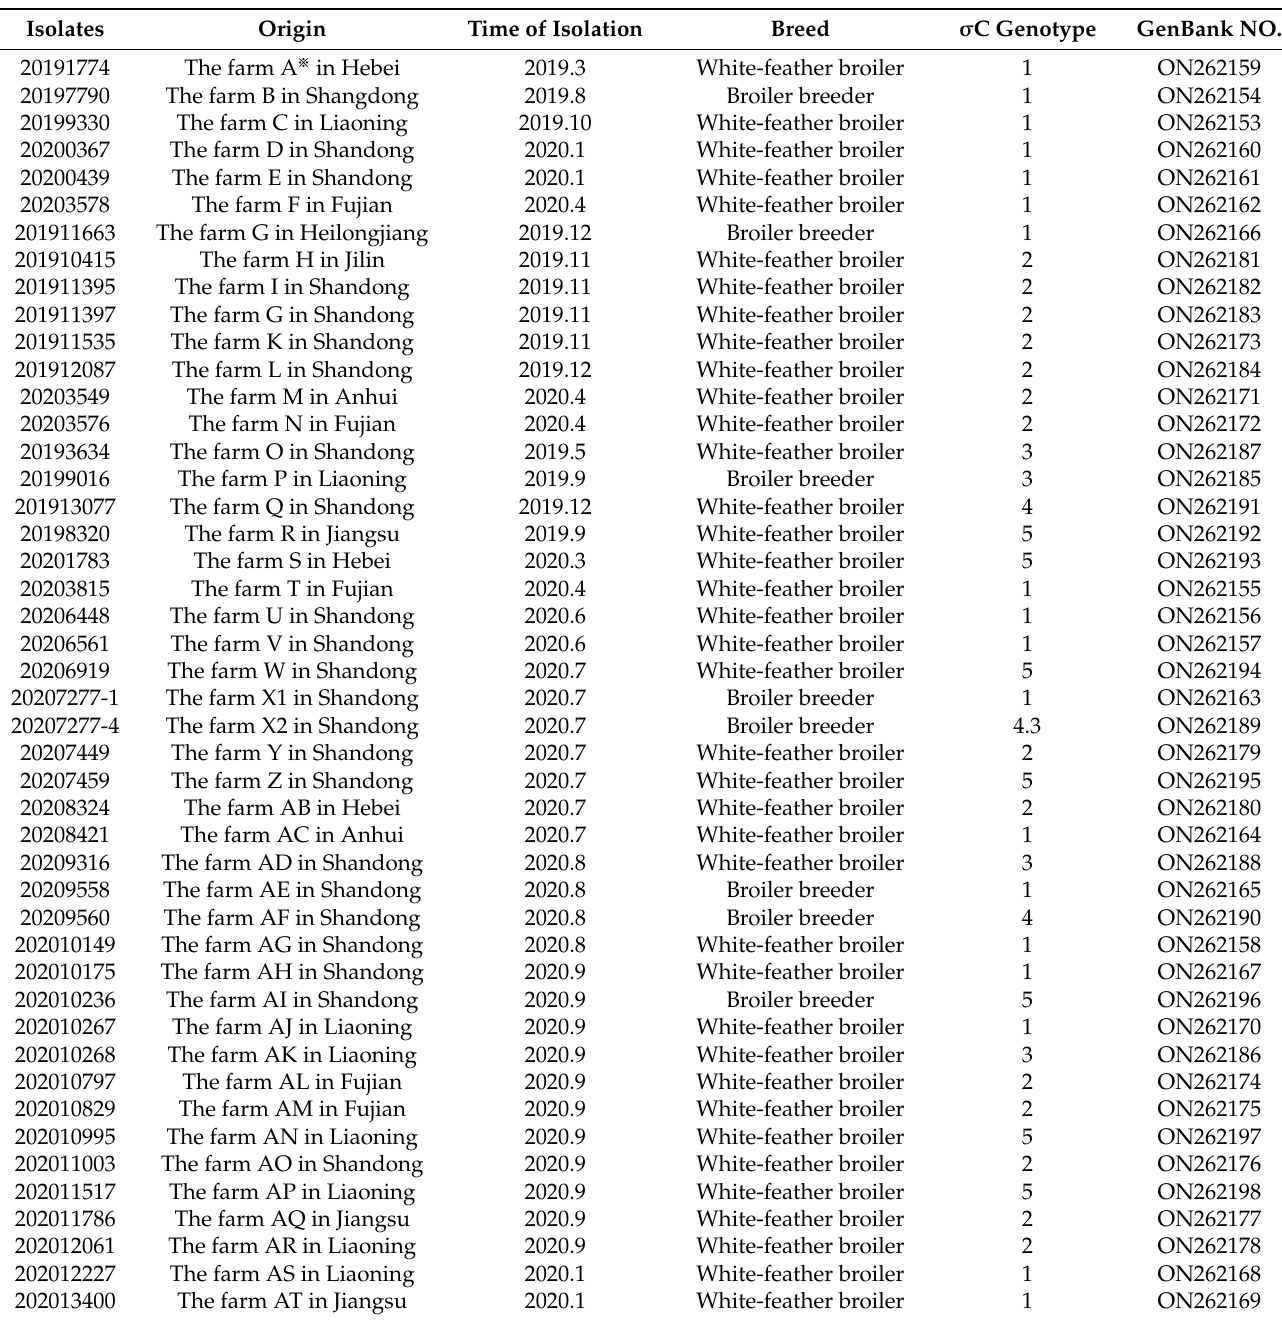
Table 2. The information of 46 Avian reovirus virus isolates. ※ Different farms were labeled as A–Z and AB-AT. Farms X1 and X2 have different hen houses than farm X.